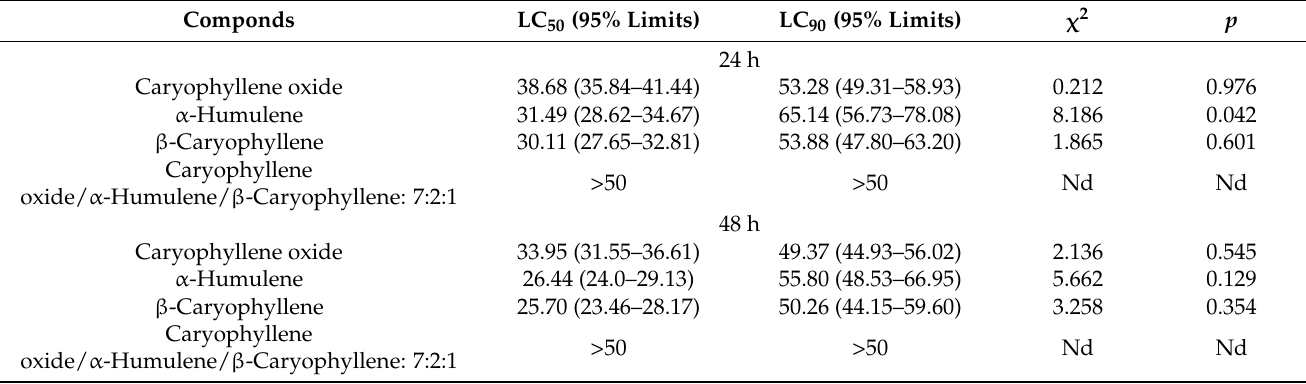
Table 3. Larvicidal activity of major compounds against Aedes albopictus ( µ